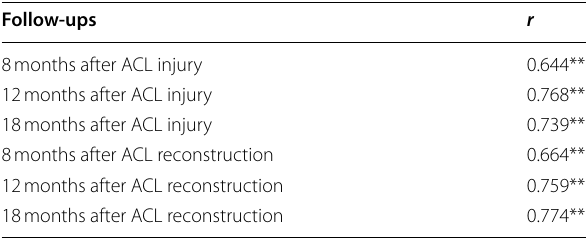
Table 6 Correlation between the subscale future of the K-SES and the